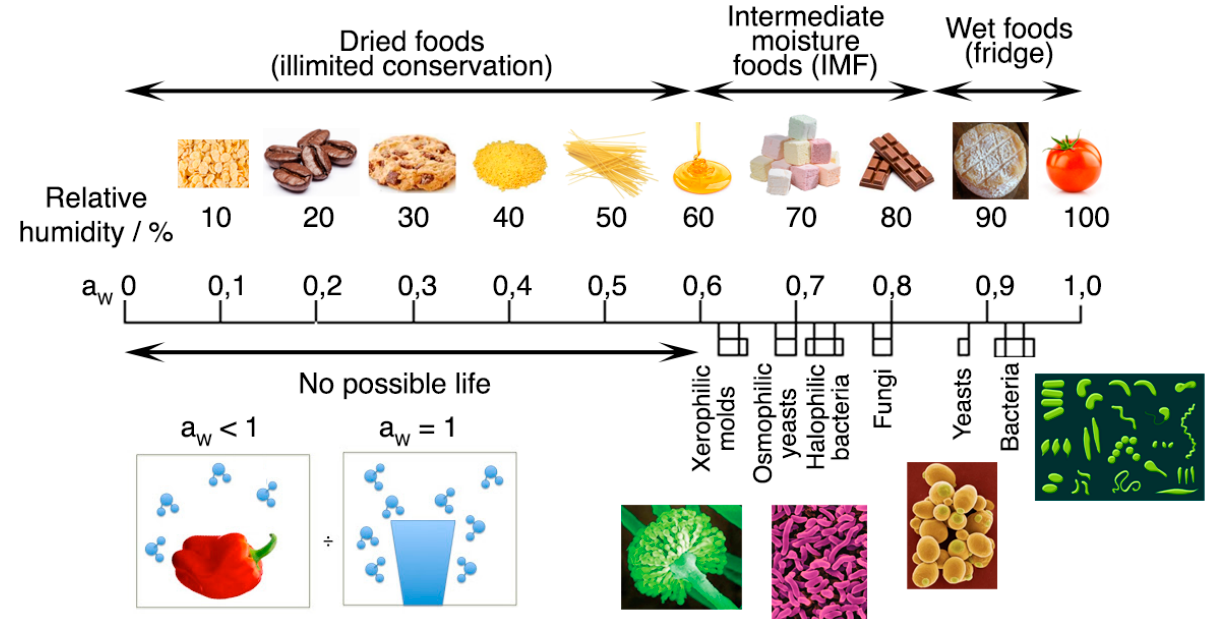
Figure 7. Water activity and growth of several kinds or microorganisms in relation woth food